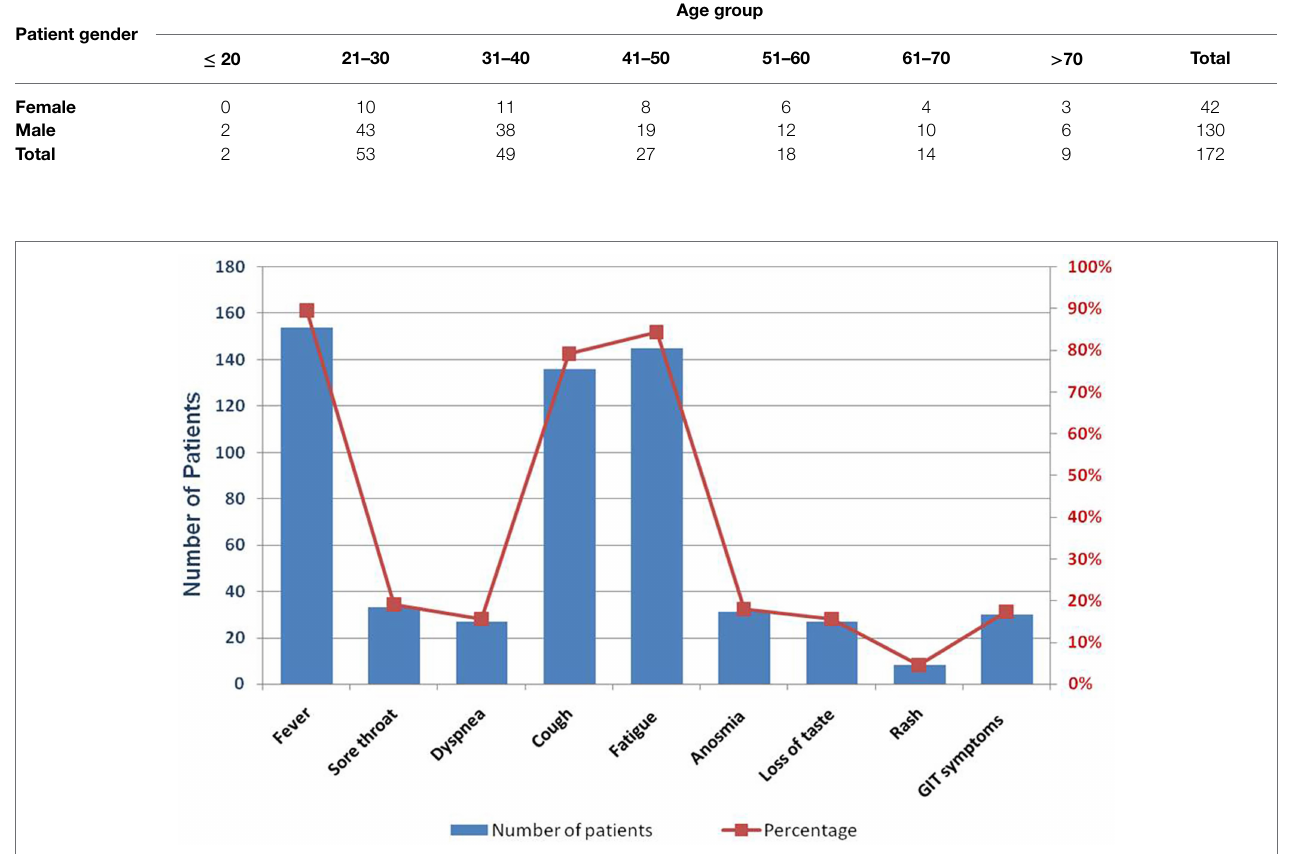
FIGURE 1 | Bar chart showing both the number of patients exhibiting COVID-19